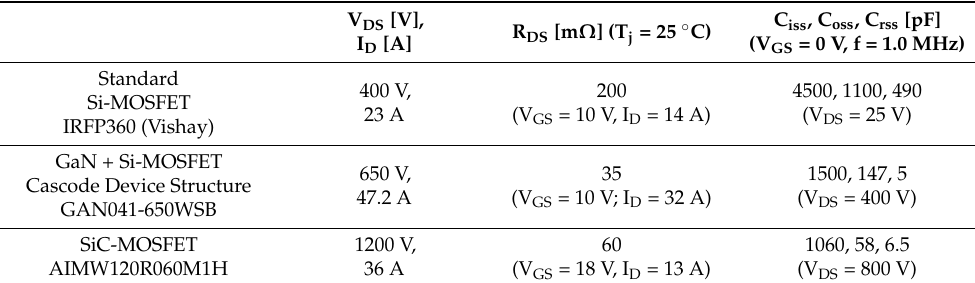
Table 1. Basic properties of the tested